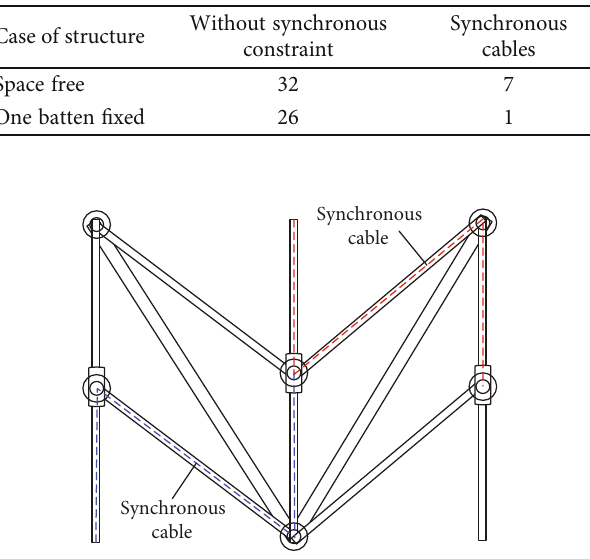
Table 3: DOFs of truss structure with fi xed length of diagonal.